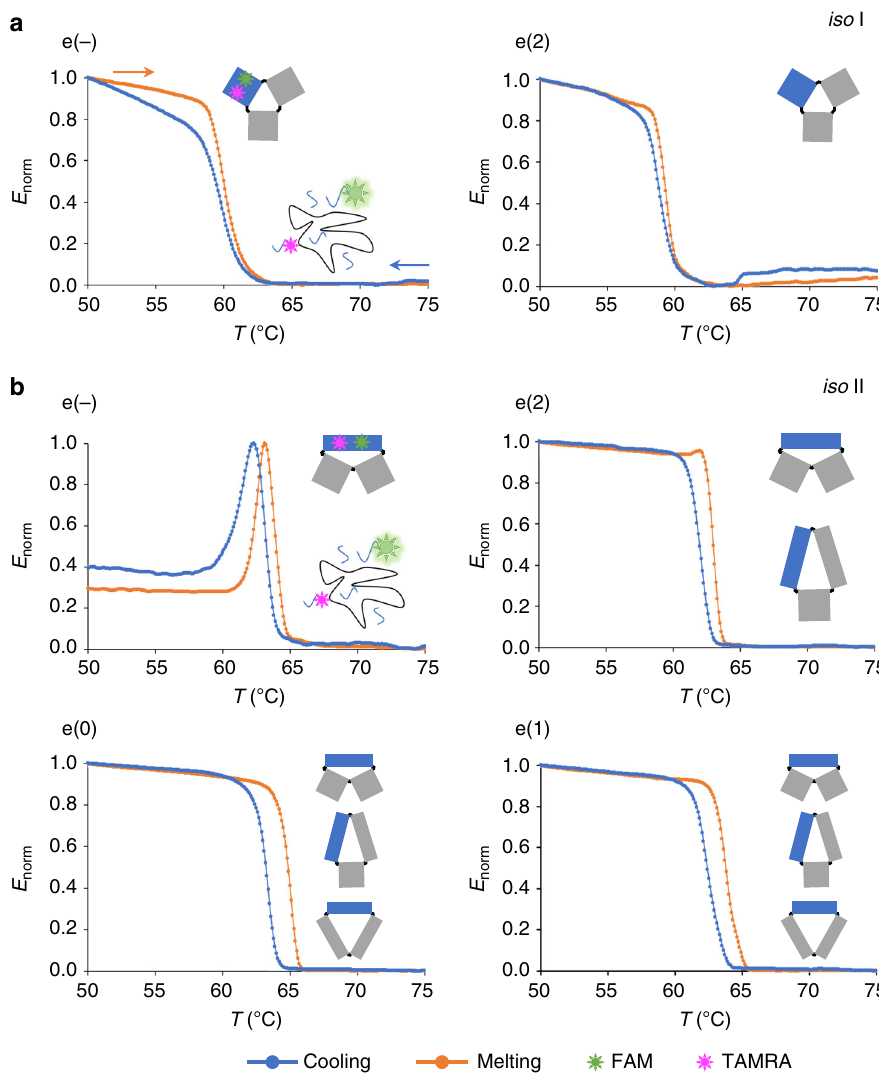
Fig. 4 Thermal-dependent ensemble FRET studies. Normalized FRET ef fi ciency pro fi les for the assembly and disassembly of domain A, either in absence of edges (e( − ) construct) or in presence of edges of type 0, 1, or 2 (e(0), e(1) and e(2) constructs). Two FRET labeling strategies (FRET I and FRET II) have been used to monitor exclusively the assembly/disassembly of the iso I ( a ) or iso II ( b ) conformer, using distinct arrangements of FAM- and TAMRA- labeled oligonucleotides belonging to the core of domain A (green and magenta symbols, respectively). All samples were exposed to cooling (blue curves) and melting (orange curves) in the range between 25 °C and 85 °C with a rate of ±0.1 °C/min. Data were averaged from four replicates of two independent experiments. The possible global isomers resulting from every edge design are schematically represented (domain A is indicated in blue). Note the quasi- reversibility of the iso I conformer and the hysteresis of the iso II form (shifted to higher T m ), particularly the biphasic pro fi le of this latter in the e( − ) construct. Source data are provided as a Source Data fi